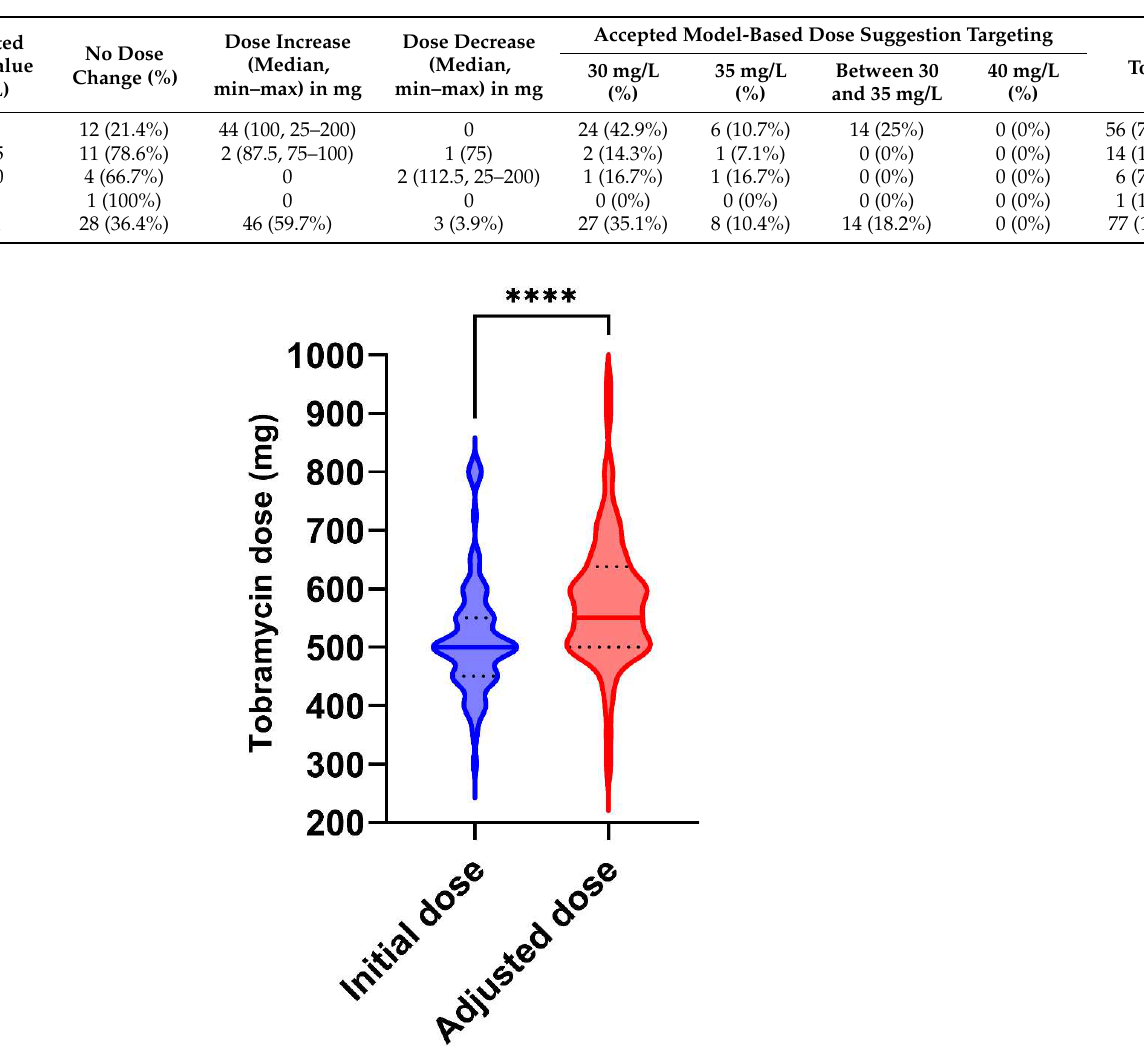
Table 3. Dose changes after model-guided TDM according to measured concentrations.